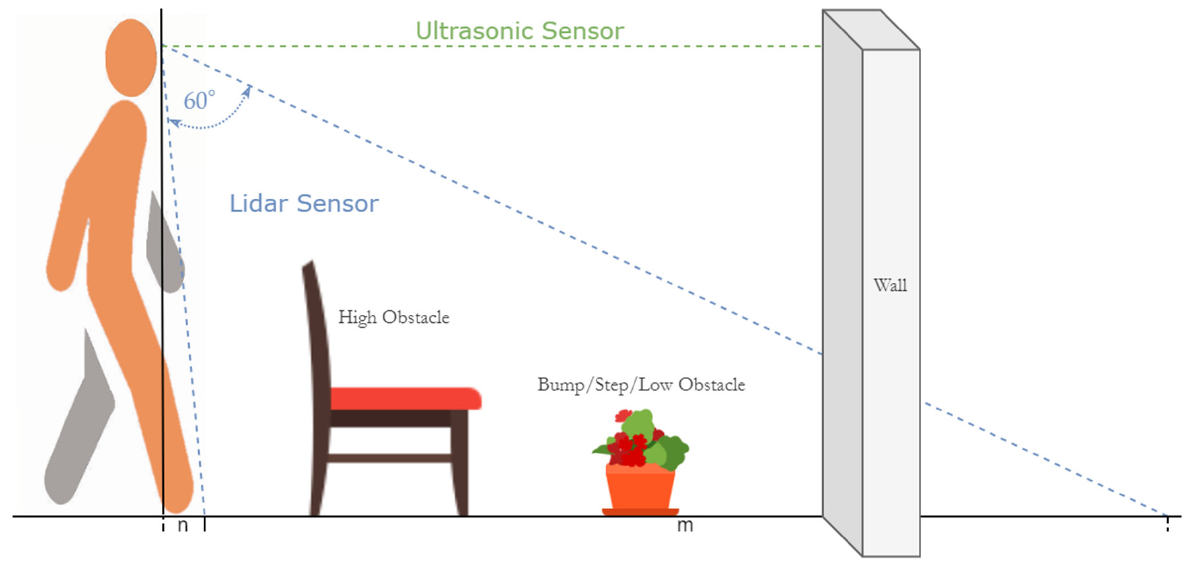
Figure 9. Sensor